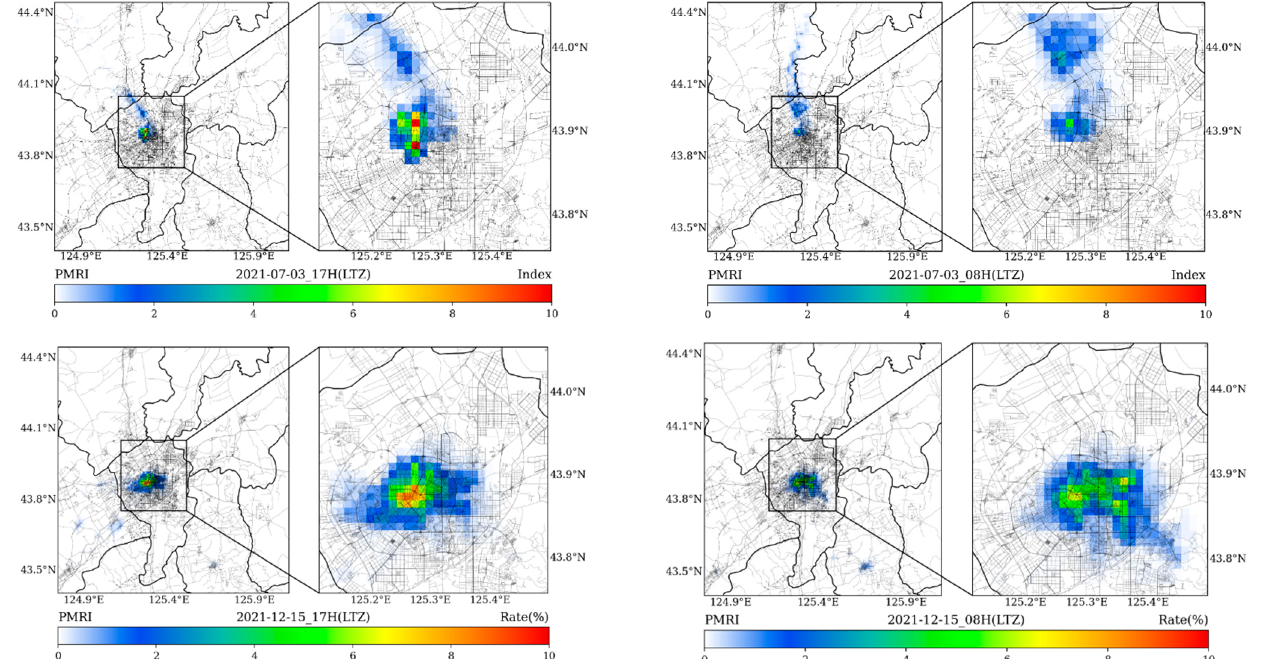
Figure 7. The spatial distributions of forecasted hourly PMRIs considering population distribution during typical hours (08H and 17H, LTZ) of traffic jams on 3 July and 15 December.